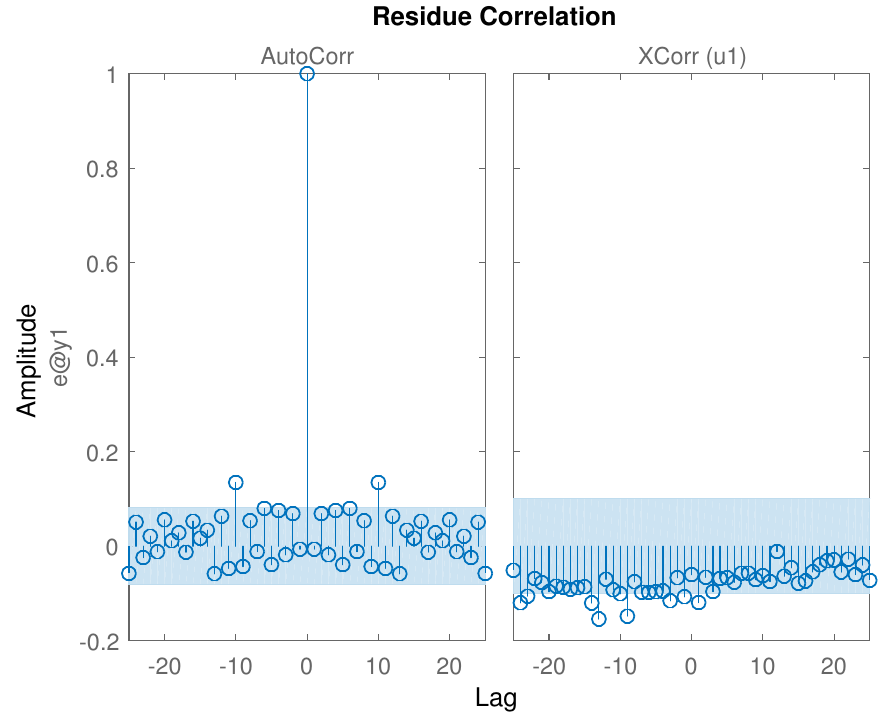
Figure 5. Residual test for validation data. Left is an estimate of autocorrelation of the residual e ( kT S ) . Right is an estimate of cross-correlation between residual e ( kT S ) and excitation signal u ( kT S ) . Covariance matrix of parameters C θ contains the information about possible variations in the model parameters which as a consequence affects the frequency response of the model G ( j ω , θ ) and H ( j ω , θ ) . As this dependence is explicit through the chosen